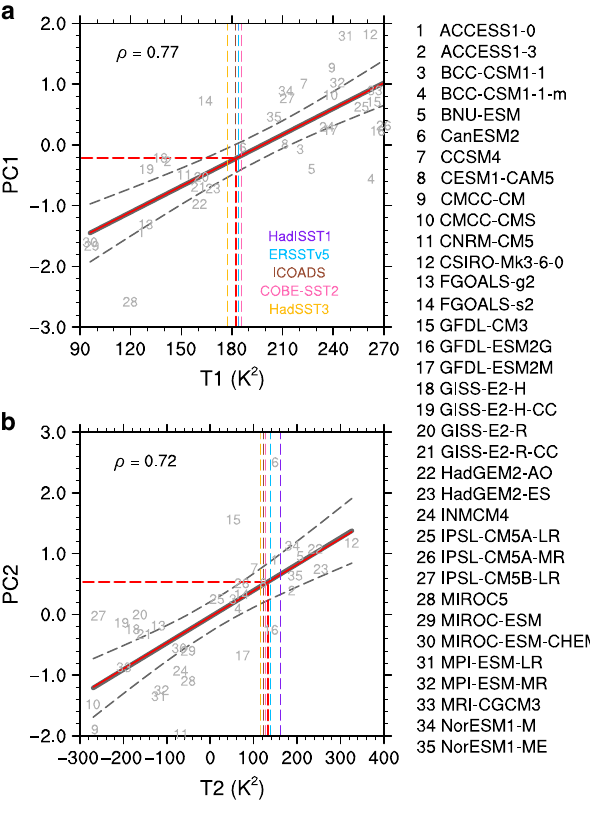
Fig. 2 Relationship between spreads in projection and historical temperature pattern. T1 in ( a ) and T2 in ( b ) (K 2 ) measure how the sea surface temperature (SST) patterns in gray boxes in Fig. 1c, d are simulated in a model ’ s historical climate, respectively (see Eqs. (2) and (3)). T1 and T2 well explain the fi rst and second principal components (PC1 and PC2), respectively, the two leading uncertainty modes of projected changes in the western North Paci fi c Subtropical High, with high correlation coef fi cients ( ρ ) statistically signi fi cant at the 1% level under Student t -test. Bold gray fi tting line is obtained by the least square method while thin red line is an observational correction based on Eq. (5). Gray dashed curves denote the 95% con fi dence range of the linear regression. T1 and T2 indices from fi ve observational SST datasets (HadISSTv1.1, ERSSTv5, ICOADS, COBE-SST2, and HadSST3; vertical thin dashed lines) are used to constrain the values of PCs. Mean of the fi ve observational results yield the optimal constraint (red dashed line).